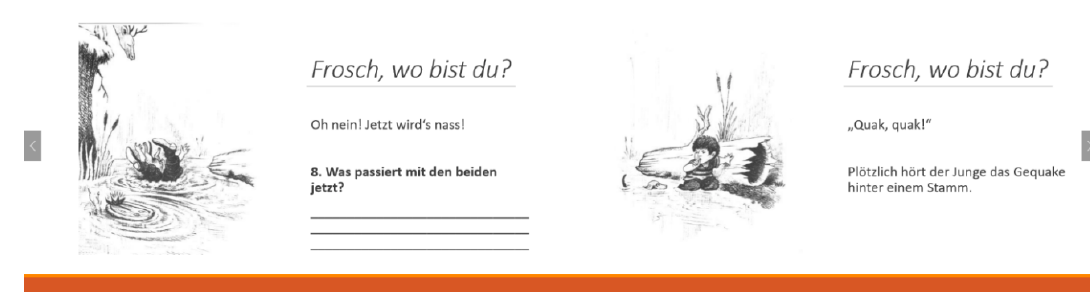
Figure A10. Pretest: Production task.